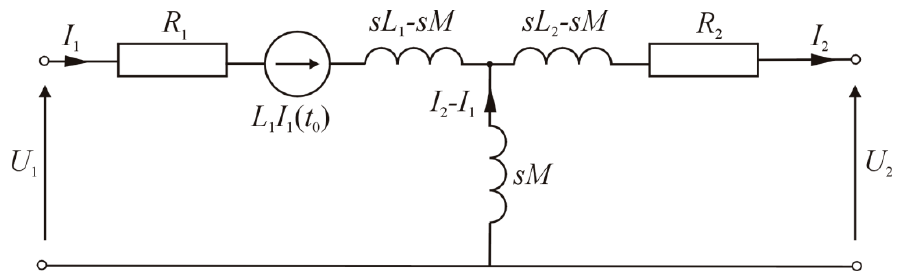
Figure 6. Operating diagram for t ≥ t 0